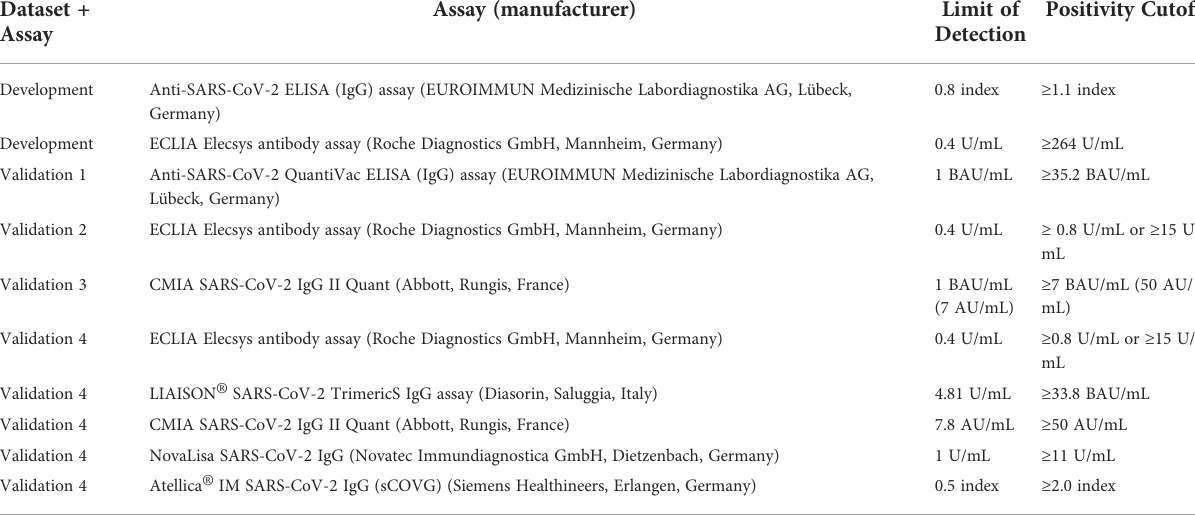
Assay (manufacturer)